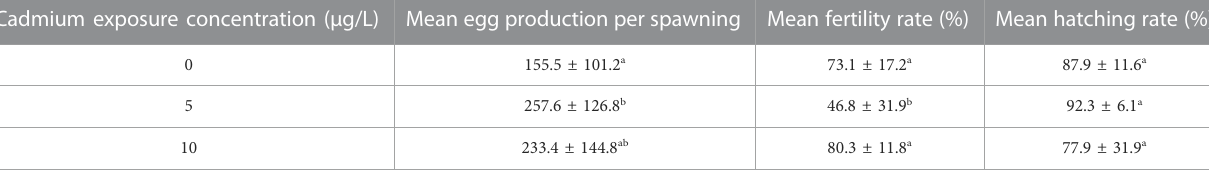
TABLE3Meanegg production perspawning,meanfertilityrate,andmeanhatchingrateofparentalrare minnows( Gobiocyprisrarus )afterCdexposure following 28 days of reproduction period.